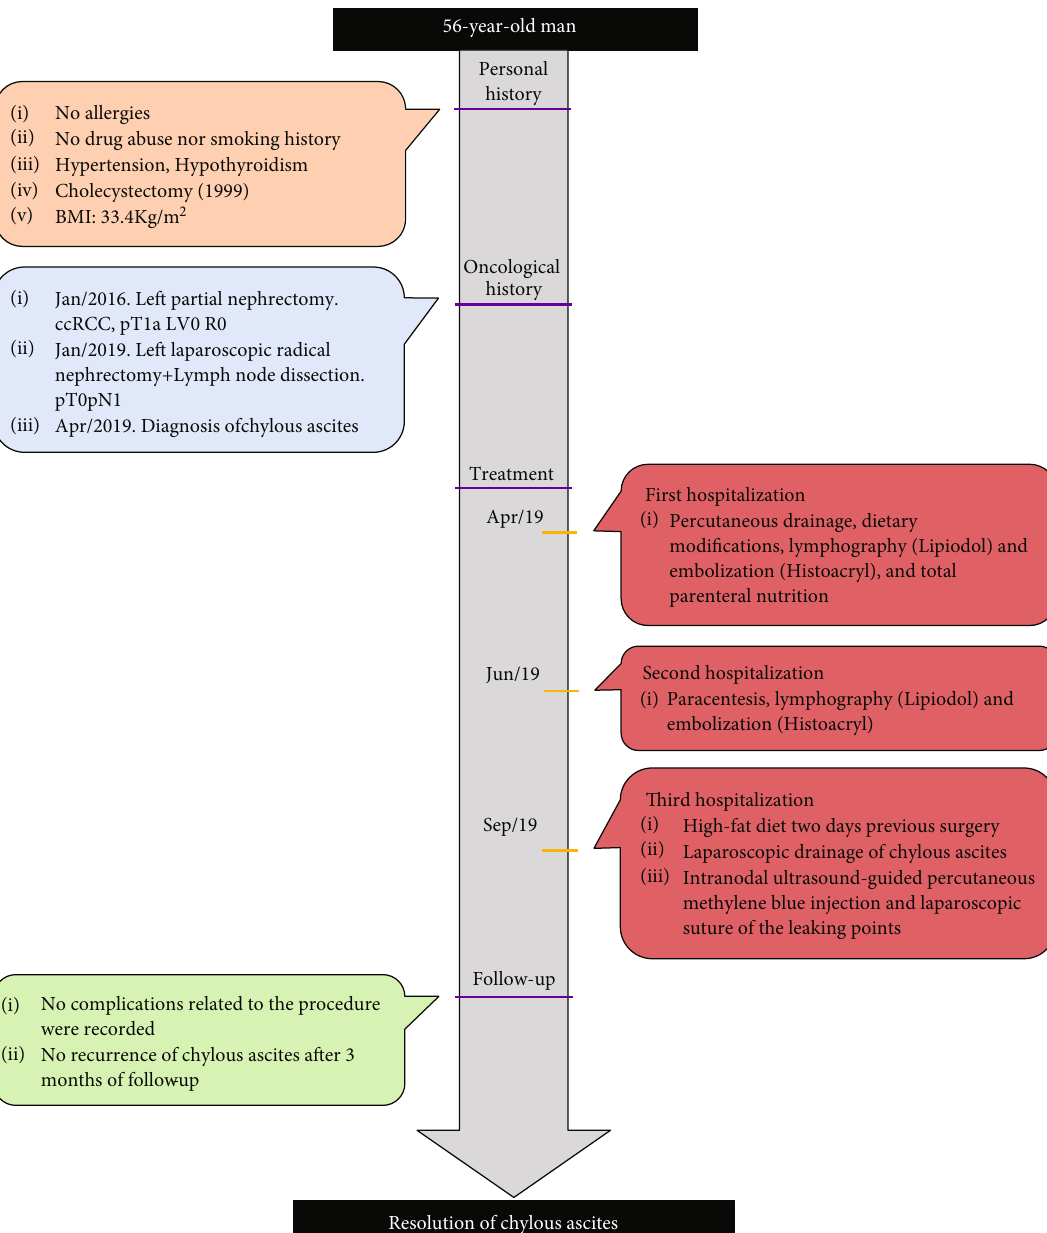
Figure 1: Timeline of interventions and outcomes. BMI=body mass index, ccRCC =clear cell renal cell carcinoma, LV=lymphovascular invasion, R =margin status.